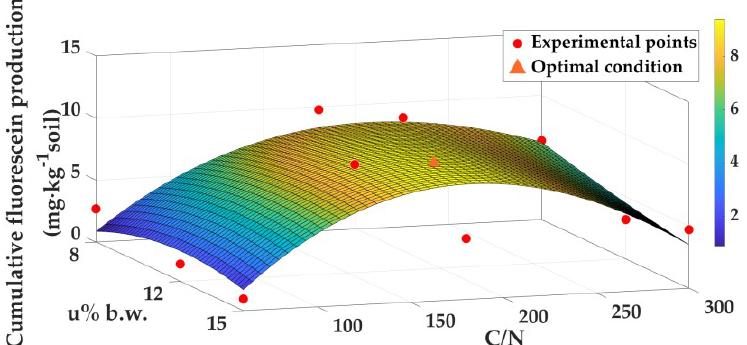
Figure 17. Response surface for fluorescein produced in 30 days.